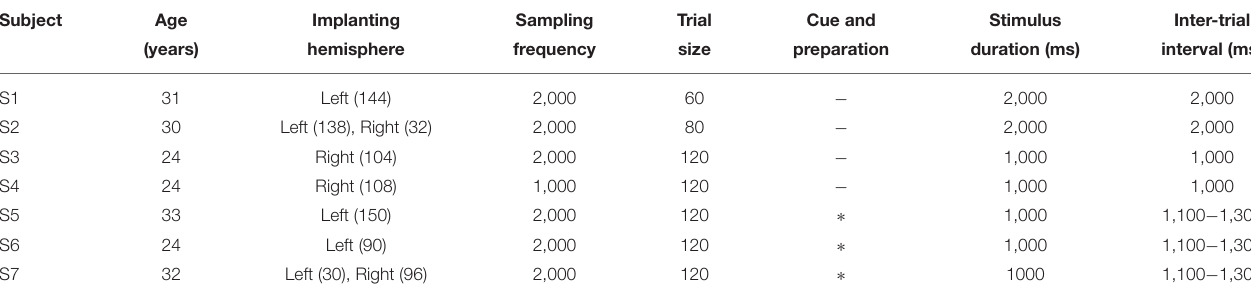
TABLE 1 | Subject demographics, implanting information, and neural recording details.